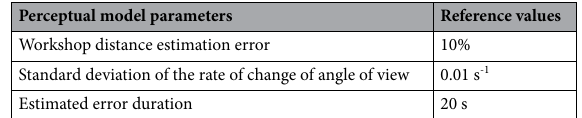
Table 2. Driver perception model-related